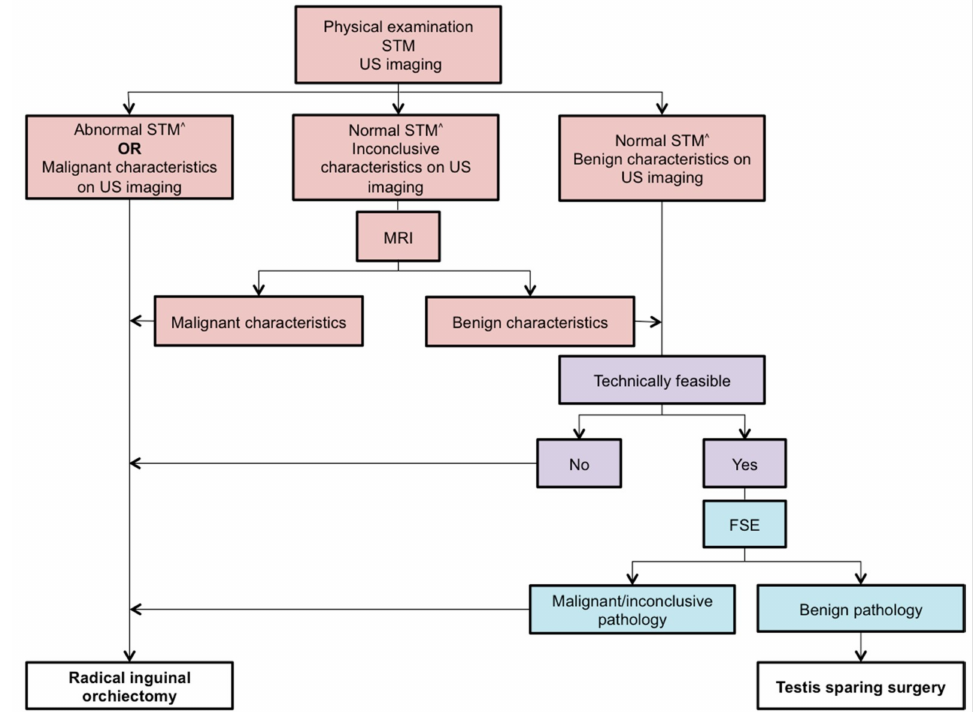
Figure 2. Our proposed algorithm for the surgical approach in prepubertal patients less than 12 years of age with testicular tumors. STM = Serum tumor markers; US = Ultrasonographic; MRI = Magnetic resonance imaging; FSE = Frozen section examination; ˆ = According to the age specific range; •